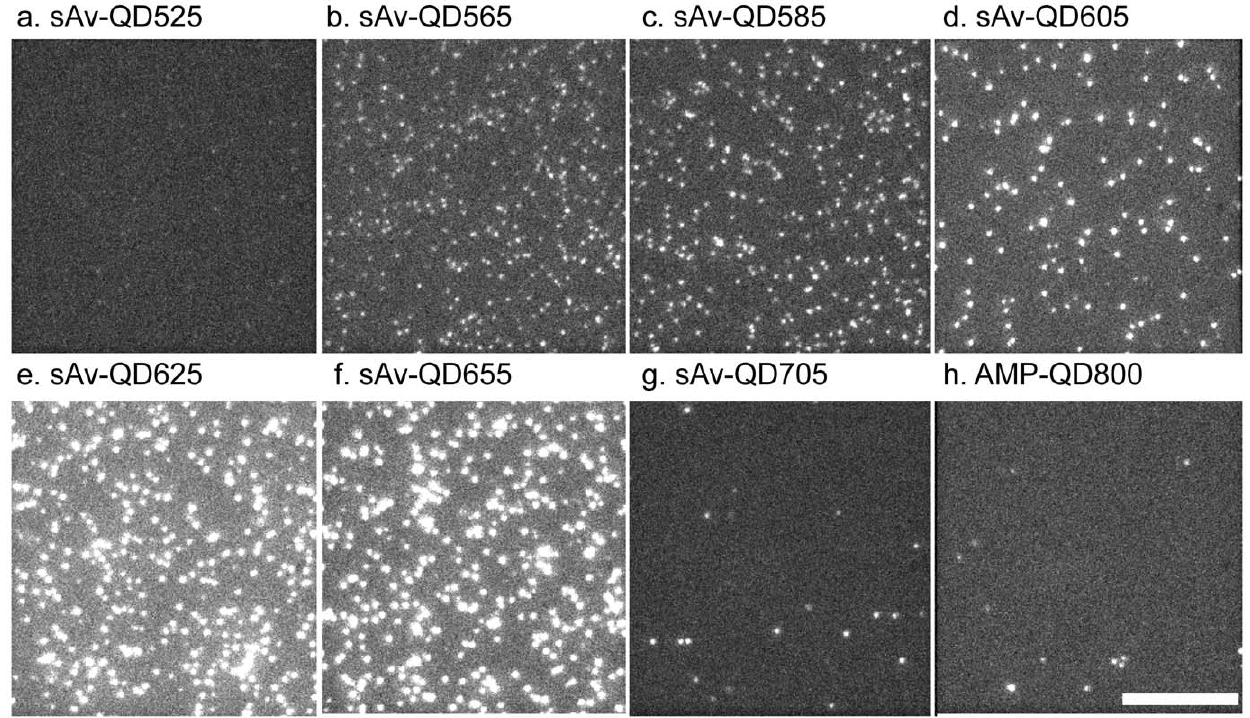
Figure 1. QD Representative single image frame comparison of the fluorescence intensities of QD525, QD565, QD585, QD605, QD625, QD655, QD705, and QD800. All images are displayed at identical brightness and contrast ratios and are directly comparable. The entire image sequence is shown in Movie S1. Scale bar equals 10 m m.